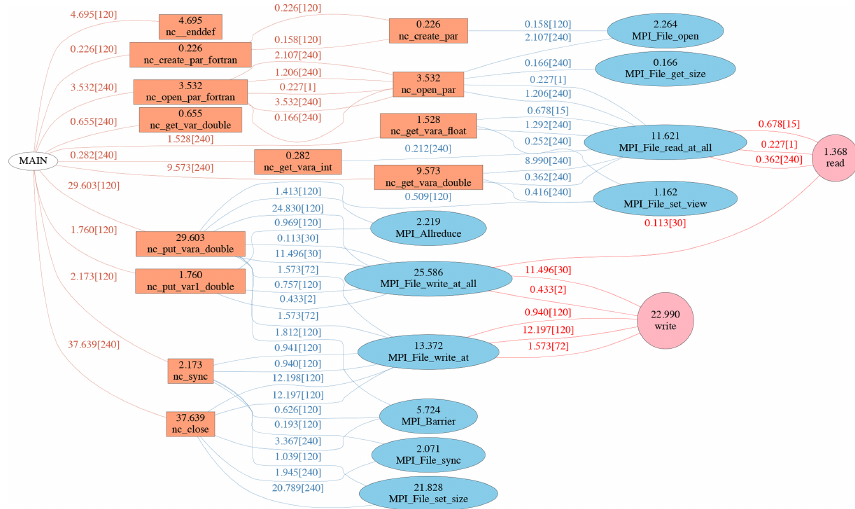
Figure 10. The call path flow of a tuned 240 PE benchmark with HDF5 1.8.20/netCDF-4. It is classified into three layers, i.e. netCDF, MPI-IO and system I / O functions. The maximum PE time together with the total number of PEs from the invoker are labelled above each path line, and the maximum PE time on each function are labelled within the node block.